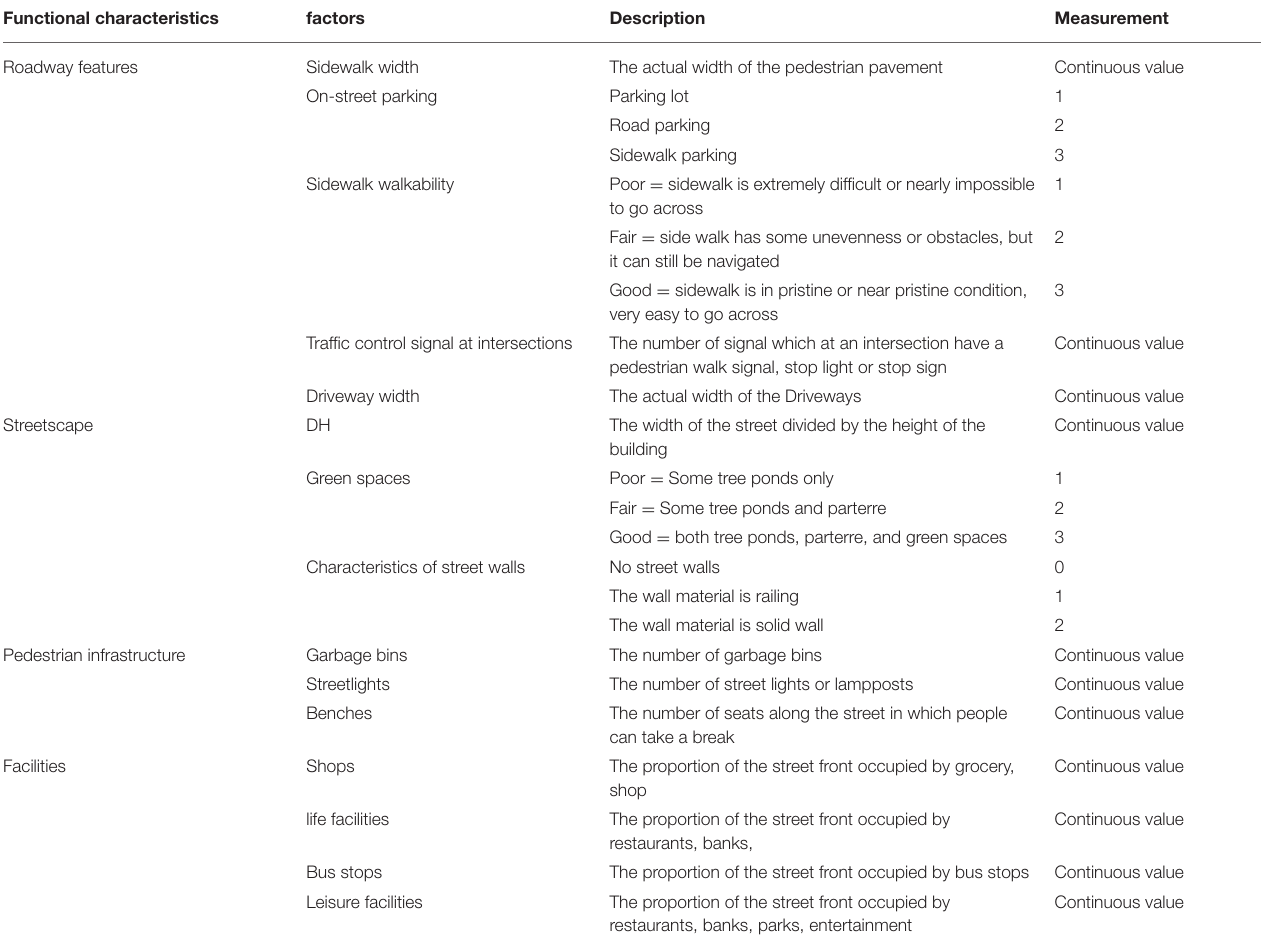
TABLE 1 | Categories and description of the street environment tool used to collect